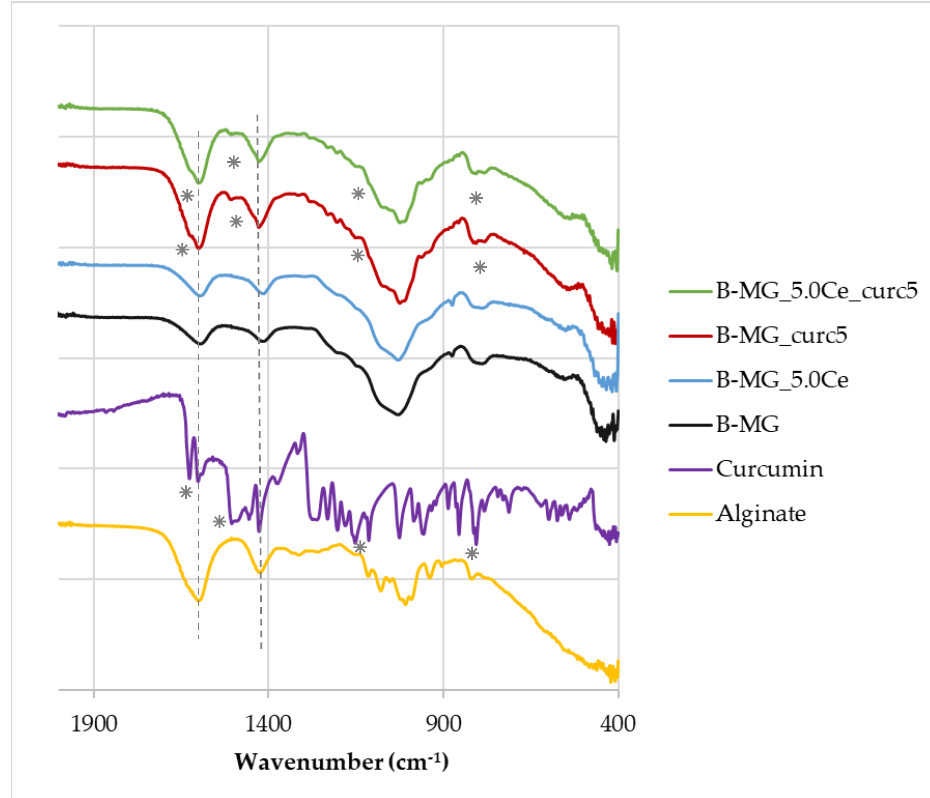
Figure 3. FTIR − ATR spectra of beads, pure alginate, and curcumin. Characteristic peaks of alginate and curcumin are highlighted by dashed lines and asterisks, respectively.